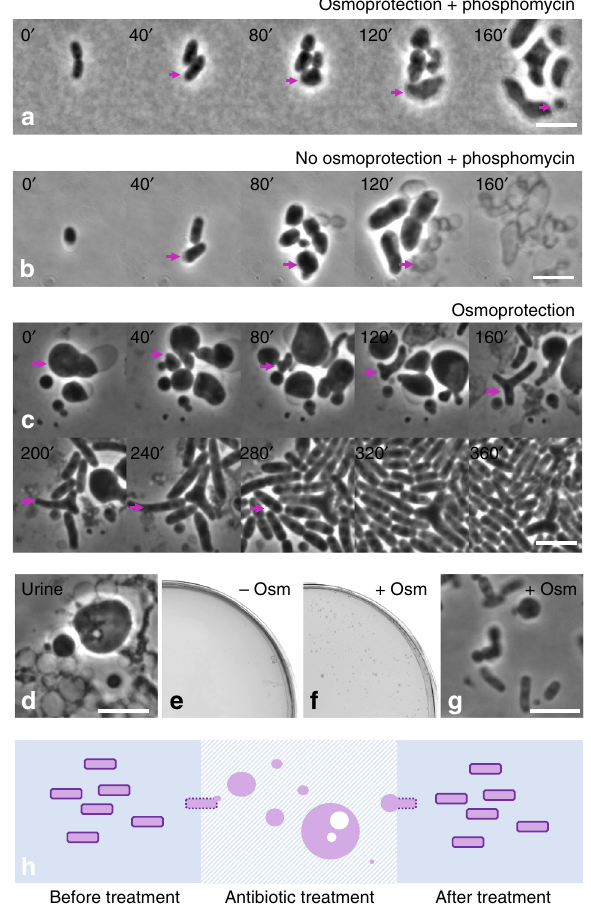
Fig. 4 E. coli transition from rod to L-form and back on osmoprotective medium and in urine. Magenta arrows indicate individual bacteria, which were followed in time lapse and described in details in the main